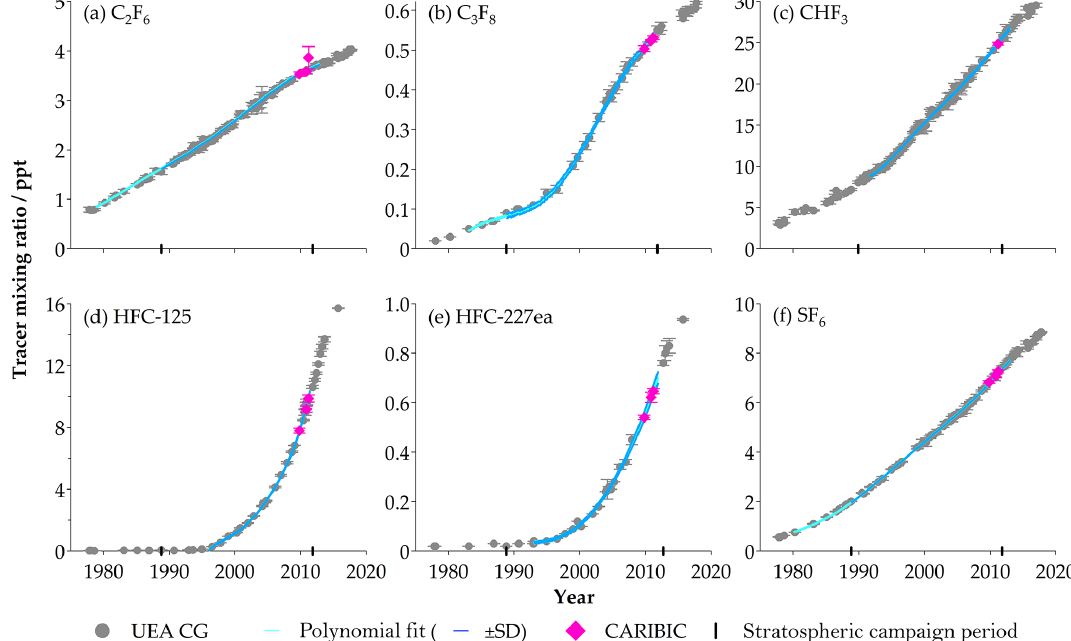
Figure 1. UEA CG time series (6-month time shift), polynomial fits applied to these time series and associated errors (see inset legend). Details of the analytical uncertainties in UEA CG time series, application of polynomial fit and comparison with CARIBIC data are provided in Sect. 2. Vertical black lines on the x axis show the section that contains the 10-year period leading up to each of the stratospheric campaigns used during the bootstrap procedure (Sect. 3(a)). Table 2. Overview of stratospheric campaigns used in this